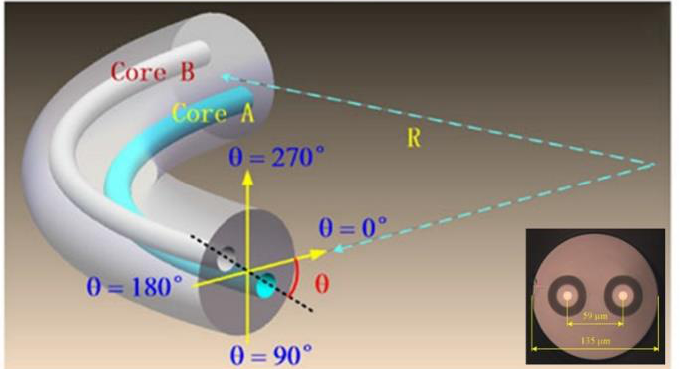
Figure 7. Schematic diagram of a curved twin-core few-mode fiber with bending radius of R, where bend direction angle θ is the angular offset between the fiber bend plane and the axis connecting core A and core B. The inset shows the microscopic image of the TC-FMF. Adapted with permission from Ref. [41] © 2017 IEEE.